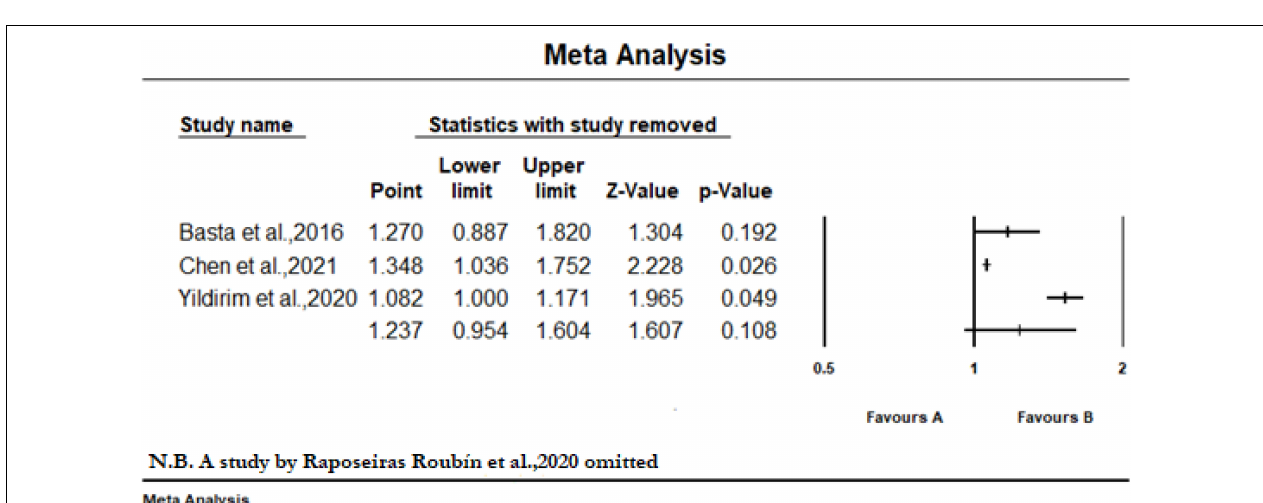
FIGURE 2 | Forest Plot showing pooled hazard ratio with 95% CI of all-cause mortality and major adverse cardiovascular events (MACE) for per point increase in CONUT score.